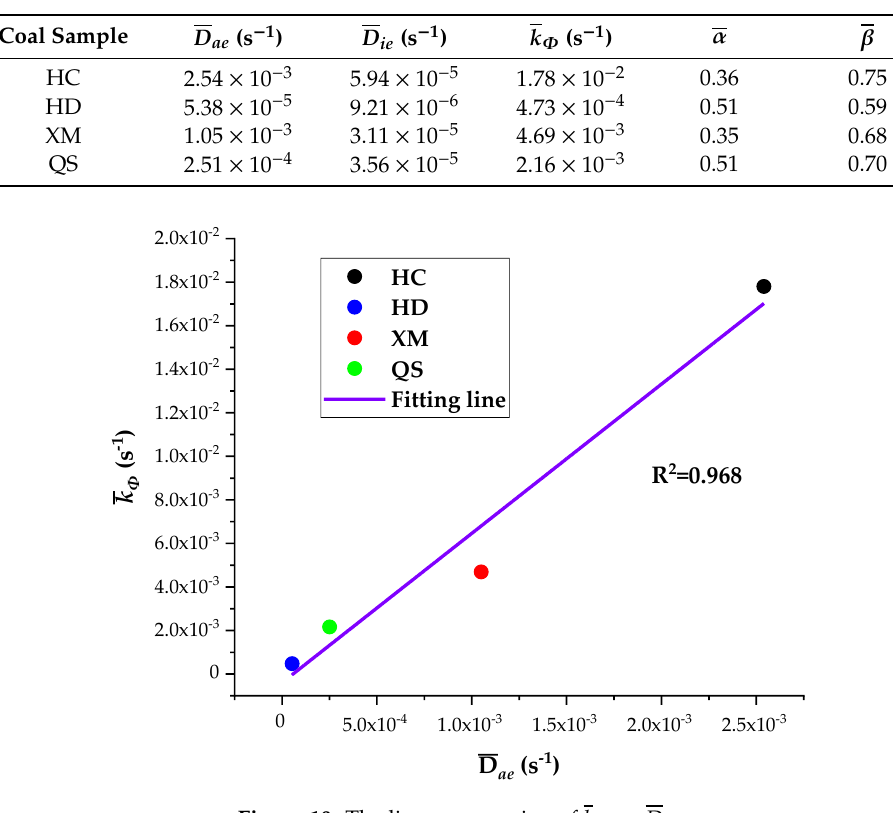
Figure 11. The linear regression of  k Φ on  D ie. The results show a good linear correlation of  D ae ,  D ie and  k Φ in our experimental results, and the goodness of fit is the best for  D ae and  k Φ . It suggests that both the diffusion coefficients D ae and D ie and characteristic rate parameter k Φ are suitable for describing the coal gas diffusion rate. The analysis above suggests that the fast diffusion coefficient D ae decreases with the increase in pressure while the slow diffusion coefficient D ie increases with the increase in pressure. k Φ keeps fixed and thus may be considered as a combined effect of D ae and D ie .